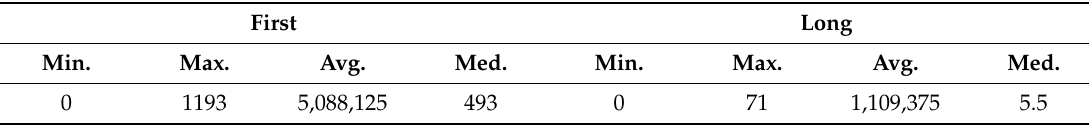
Table 5. First and long precedencies by